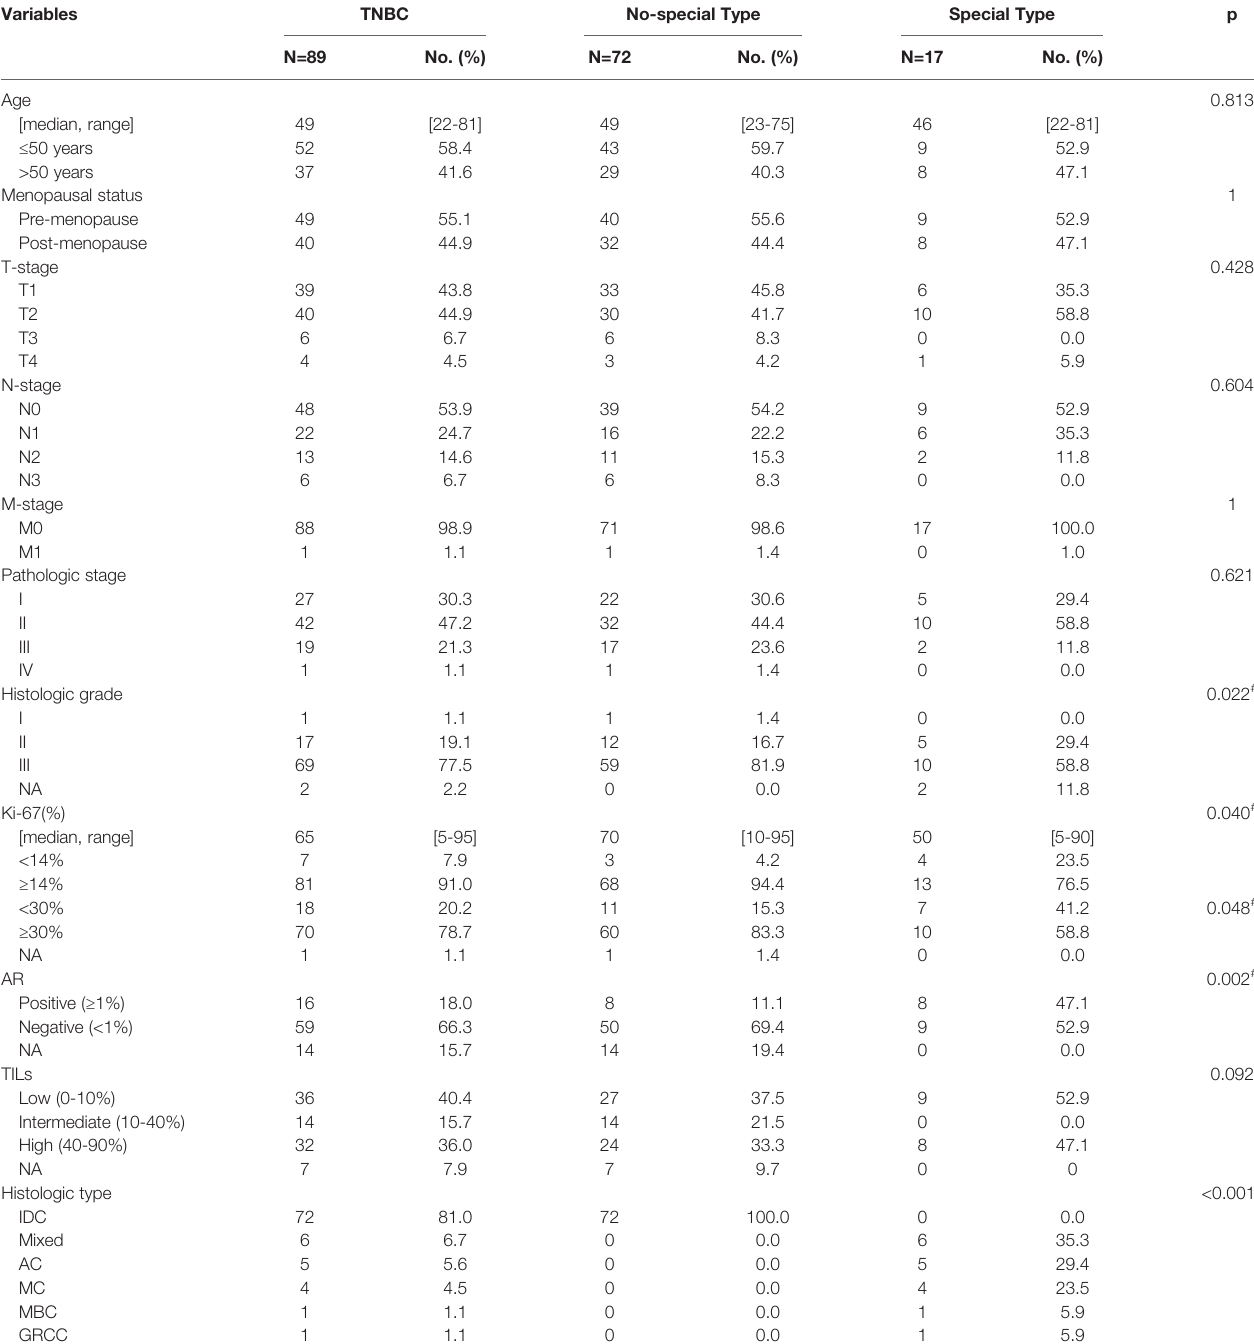
TABLE 1 | Clinicopathologic characteristics of the GDPH TNBC cohort